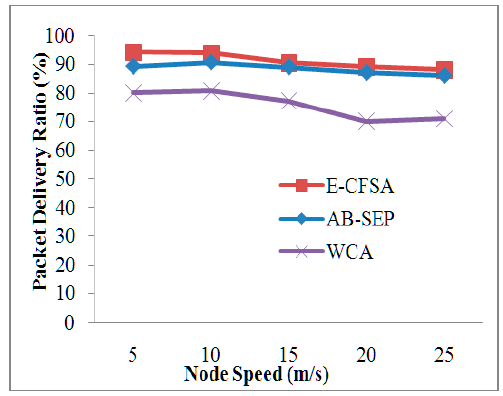
Figure 10. Graph PDR Vs. Network size.